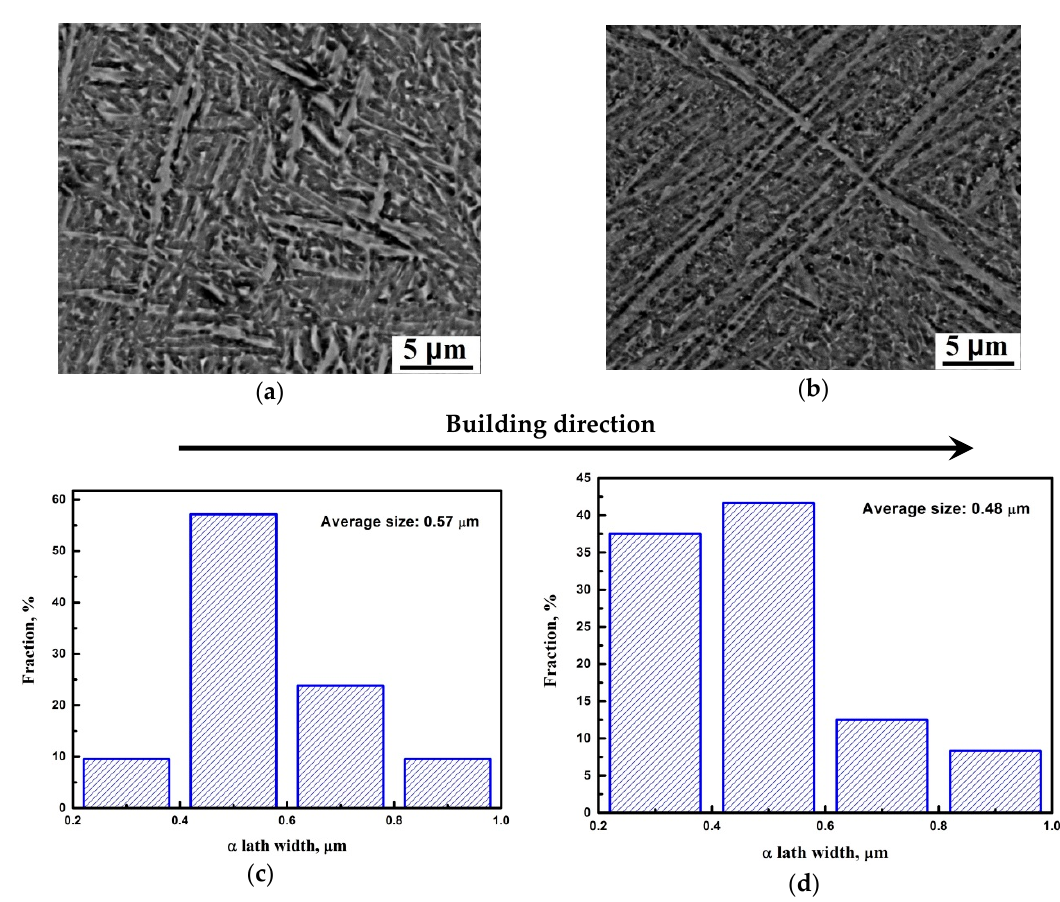
Figure 2. SEM images of the samples ( a , b ) and histogram ( c , d ) of the thickness distribution of α plates, respectively: ( a , c )—S1; ( b , d )—S2.